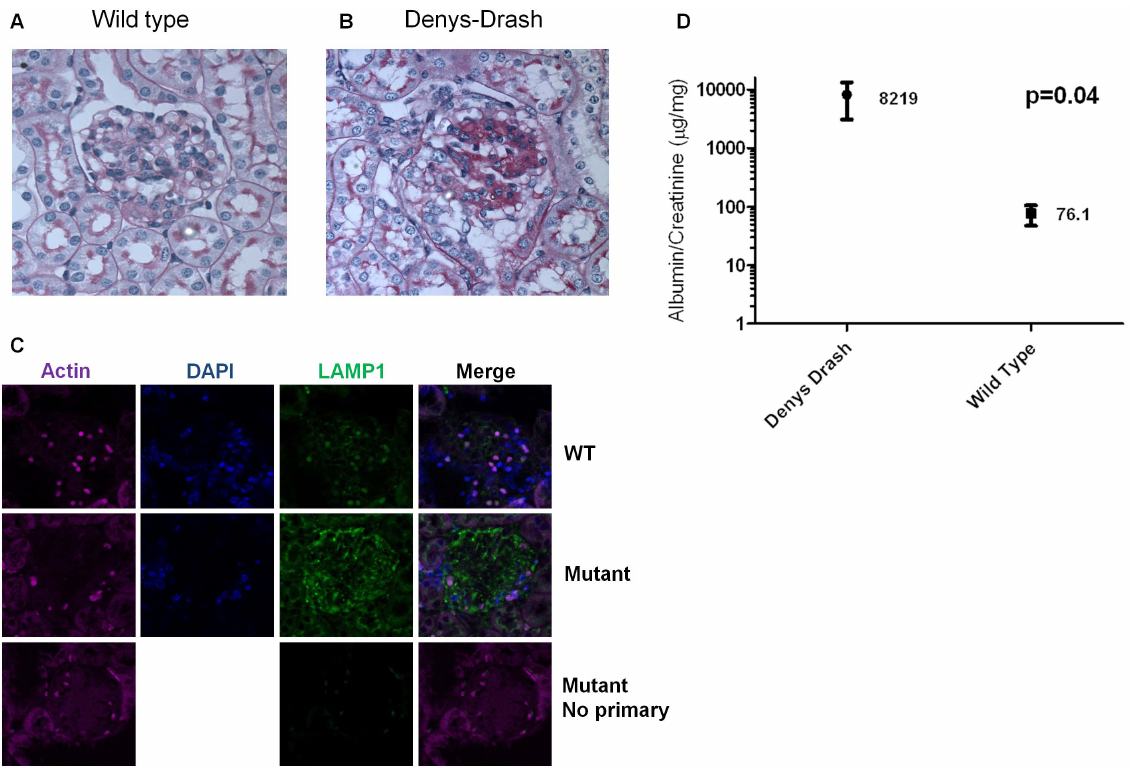
Figure 7. Albuminuria, glomerulosclerosis, and lysosomal associated membrane protein 1 (LAMP-1) staining was increased in Denys-Drash mice compared to control mice. Representative periodic acid-Shiff (PAS) staining of glomeruli from A) wild type and B) Denys- Drash mice. Glomerulosclerosis was qualitatively increased in Denys-Drash mice compared to controls. Representative fluorescence staining for LAMP-1 (green) in glomeruli from C) Denys-Drash and wild type mice. LAMP-1 staining was qualitatively increased in Denys-Drash mice compared to controls. LAMP1 staining appeared to be most prominent in podocytes as demonstrated by the increased intensity at the periphery of the glomerulus. The round bodies within the glomeruli that stain non-specifically for actin and LAMP1 are erythrocytes. E) Urine albumin to creatinine ratios were increased at 4 weeks in Denys-Drash (n=3) compared to wild type (n=5) mice. (Shown here on a logarithmic scale as mean 6 SEM, p=0.04).